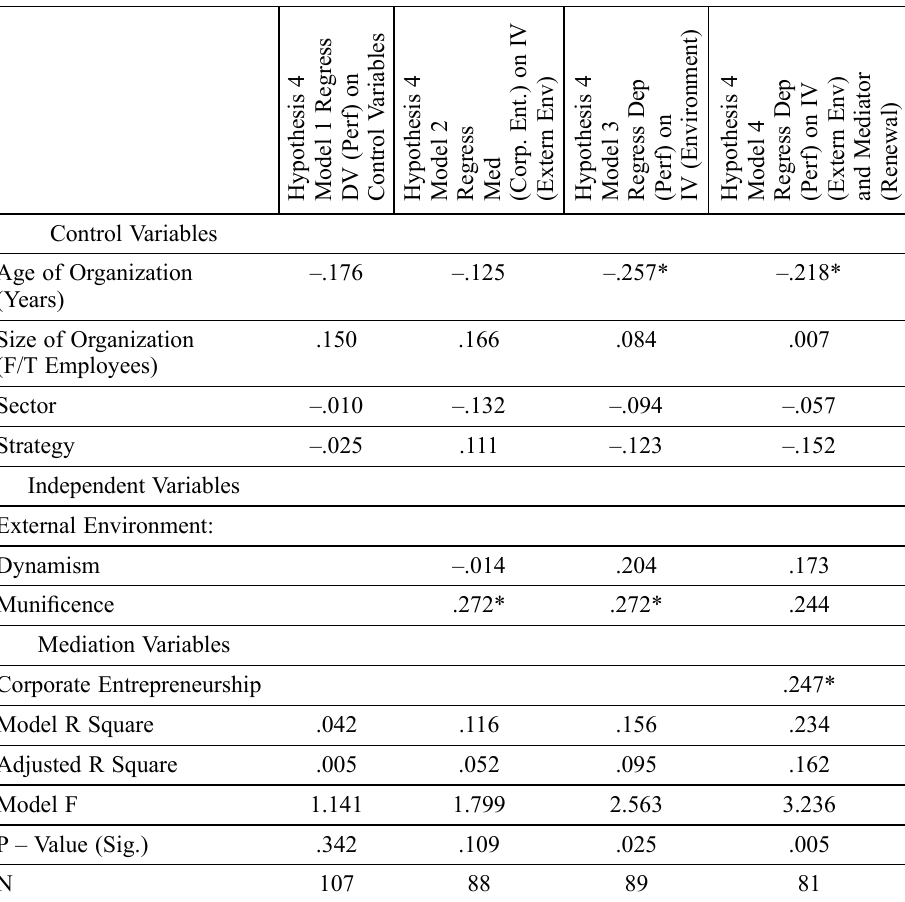
Table 9. Hierarchical regression analysis results – hypothesis